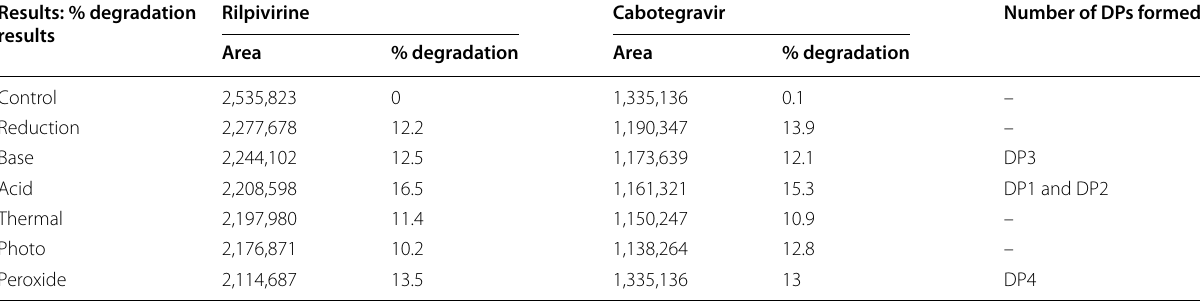
Table 8 Stress degradation